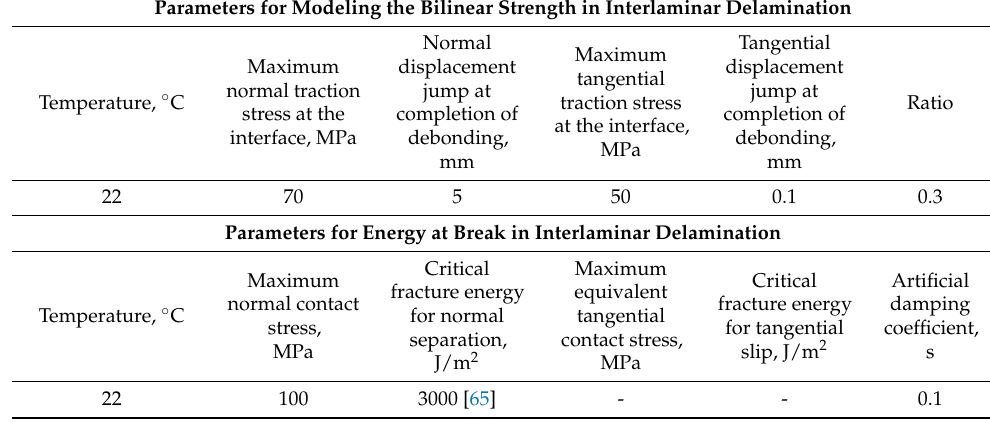
Table 7. Parameters for modeling the bilinear strength and energy at break in interlaminar delamina- tion (values selected by the